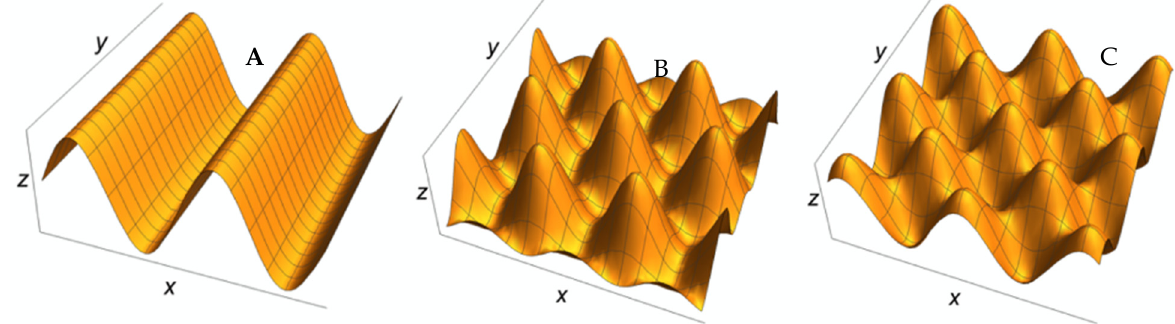
Scheme 2. Surface plots of commonly observed arrangements of convective flow cells. ( A ) Rolls, ( B ) hexagonal cells, ( C ) square cells.